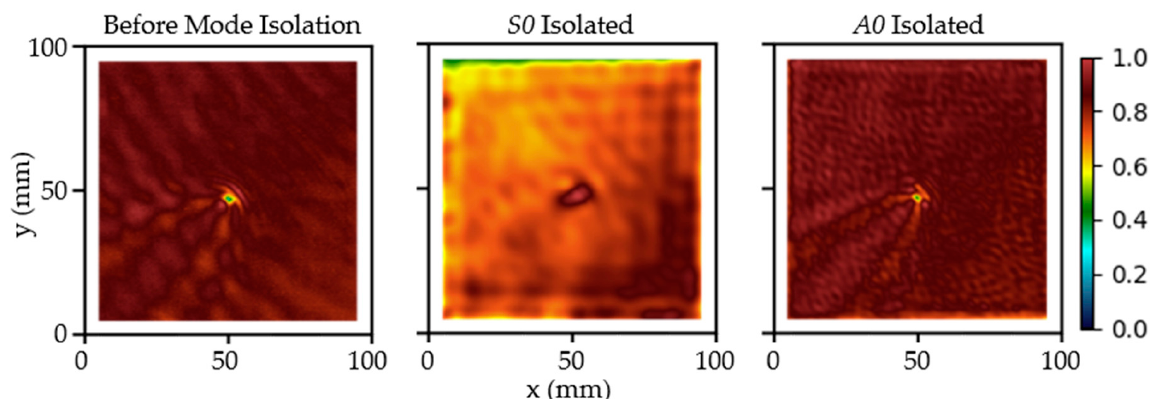
Figure 9. Spectral energy maps of Case D1 processed from un fi ltered ( left ), S0 -isolated ( middle ), and A0 -isolated data ( right ). A point-like damage could be seen at the centre of the maps.